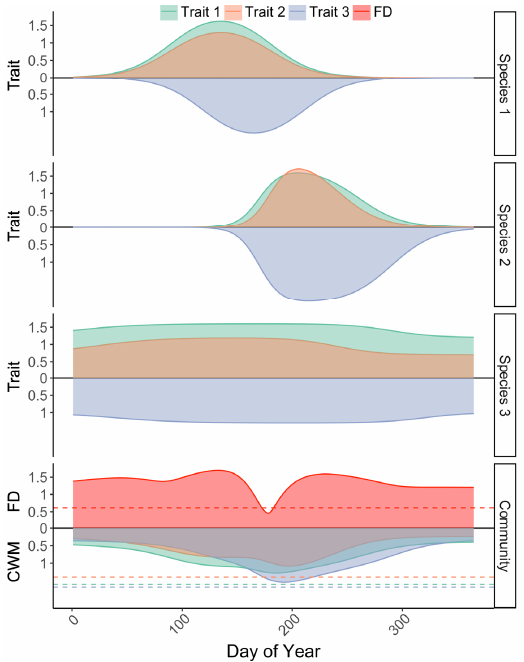
Figure 1. Hypothetical View of Time-Varying Plant Trait and Functional Diversity Here, the first three panels show the hypothetical seasonal profiles of three traits for three species (equal abundance). In the bottom panel, the temporally varying FD and community-weighted mean (CWM) of each trait are computed at any day of the year by applying the multivariate FD algorithm, the functional dispersion [36], and the CWM algorithm, respectively. The dashed lines in the bottom panel indicate the values of FD and CWMs computed using a species–trait matrix with traits of each species reaching their maximum value within a growing season, which is a common practice in plant ecology. The decrease in FD around June/July indicates the moment when the mean distance from each species to the centroid in the multidimensional trait space reaches the minimum value within a growing season, or, in other words, when species appear to be most similar to each other in terms of the values of the three traits selected. Such a temporally varying phenological aspect of traits has been documented in previous literature [34–35]. Third, there is a critical vertical scale mismatch. A plant community consists of not only canopy species but also sub-canopy species. Field measurements have the potential to sample all of them but due to the limited penetration capacity, remote sensing (especially in the optical domain) has a limited capability in measuring the vertical profile of canopy spectra [14]. This leads to an underrepresentation of sub-canopy species in remote sensing-based FD. In addition, there can be other intrinsic differences between satellite and in-situ measurements. For instance, satellite measurements can potentially have larger uncertainties than in-situ sampling